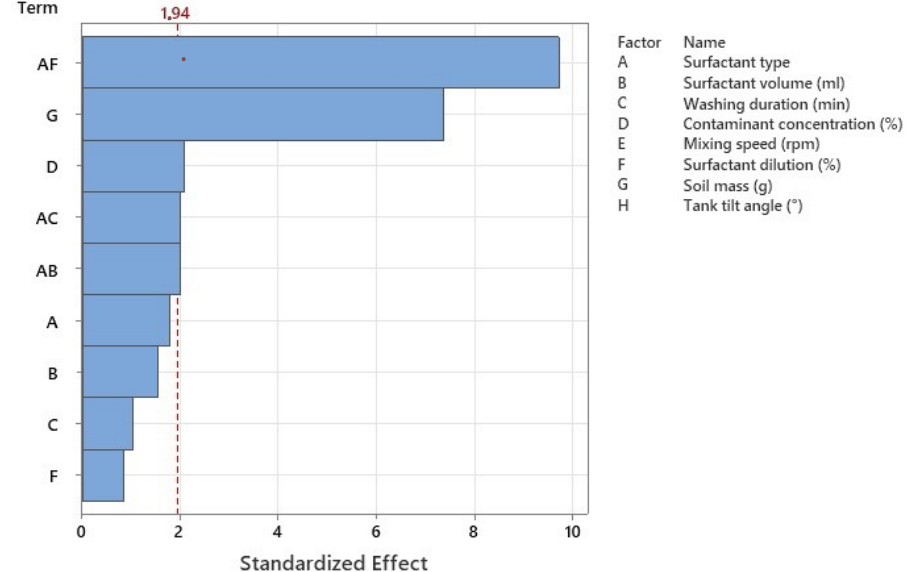
Figure 3. Pareto Chart of the standardized effects of the independent variables on the oil removal (%), α = 0.1.